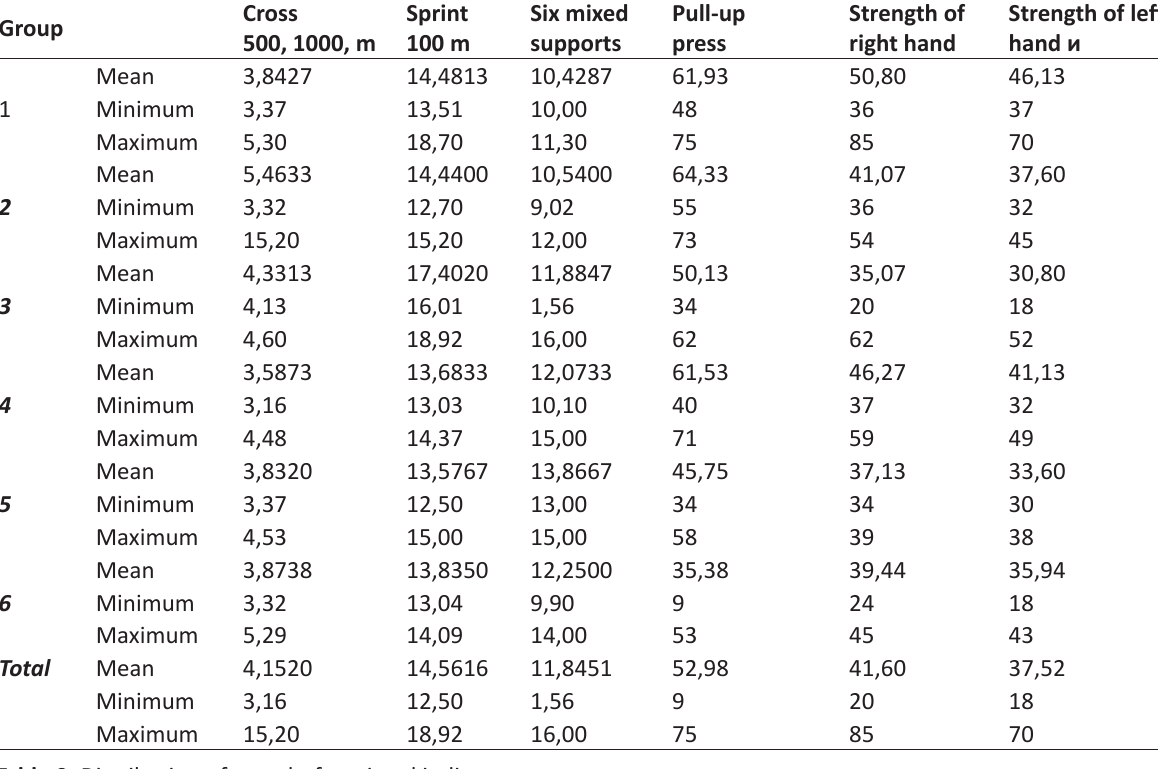
Table 8. Distribution of indicators of physical readiness